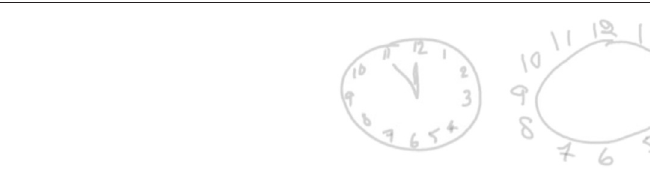
FIGURE 8 | Clock drawing based on category. From left to right: Healthy, MCI,